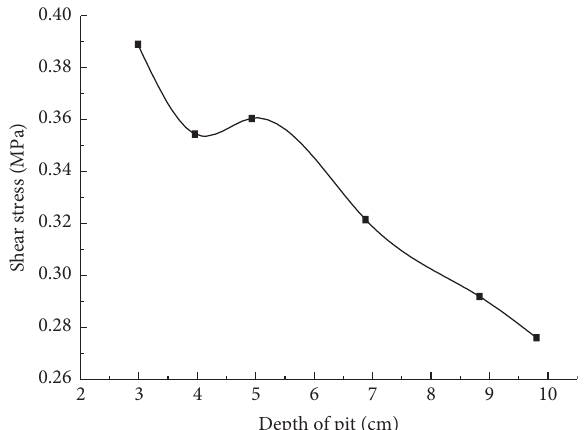
Figure 19: The effect of depth of pit on shear stress of leveling layer.